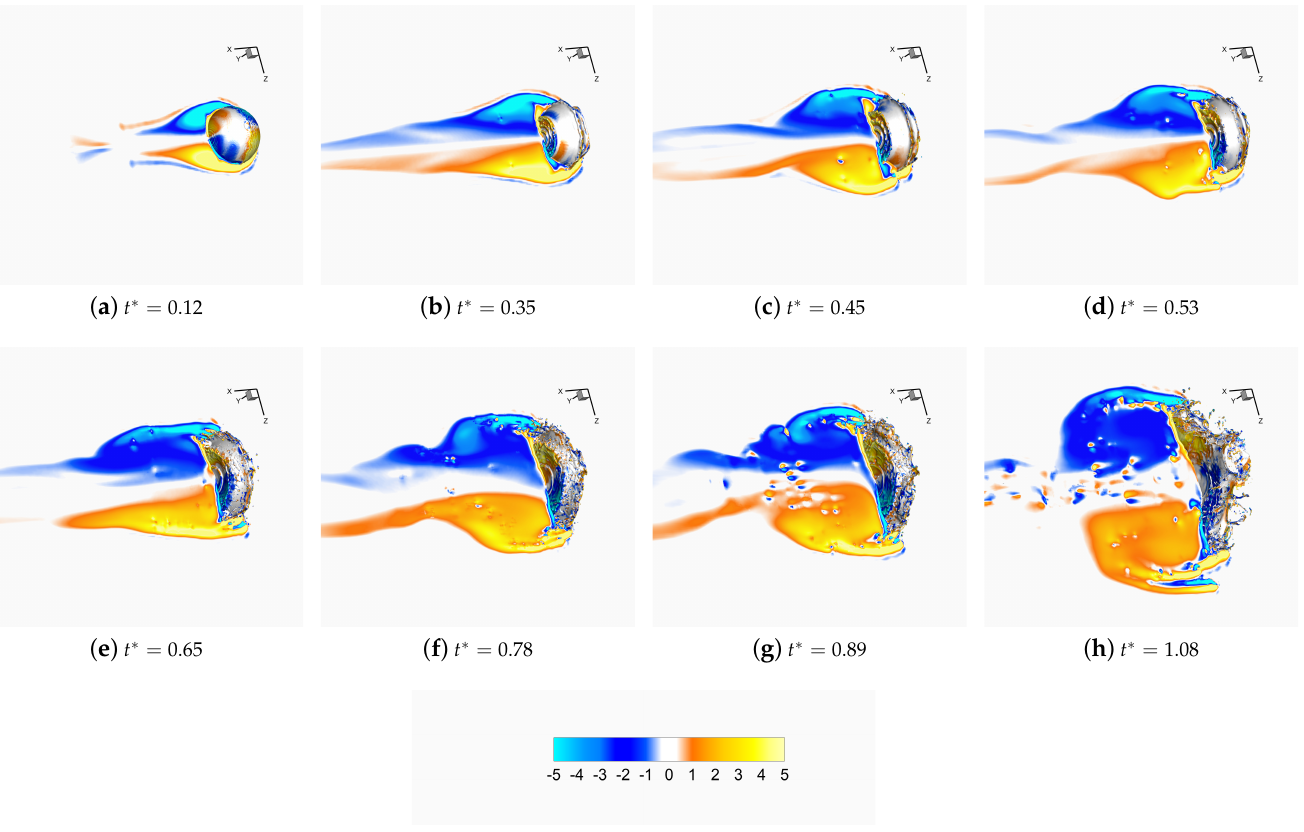
Figure 3. Normalized vorticity contours depicted in the midplane y = 0, as well as on the droplet boundary, at eight typical time